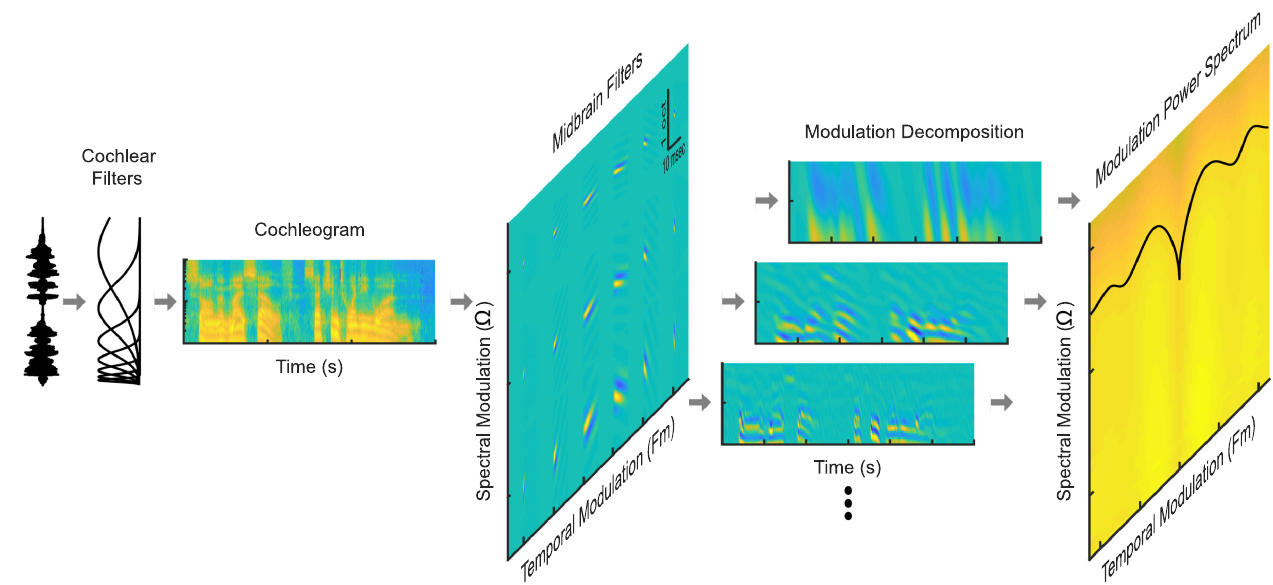
Fig 1. Using a multi-stage auditory system model to measure the modulation power spectrum of natural sounds. A cochlear filterbank stage first decomposes the sound pressure waveform (show for speech) into a spectro-temporal output representation (cochleogram). The cochleogram is then decomposed into modulation bands by a bank of spectro-temporal receptive fields (STRFs) of varying resolution modeled after the principal auditory midbrain nucleus (inferior colliculus). The resulting multi-dimensional output represents the sounds in frequency, time, temporal modulation, and spectral modulation. The modulation power spectrum (MPS), as measured through this auditory midbrain-inspired representation, is generated by measuring and plotting the power in each of the modulation band outputs versus temporal and spectral modulation frequency.